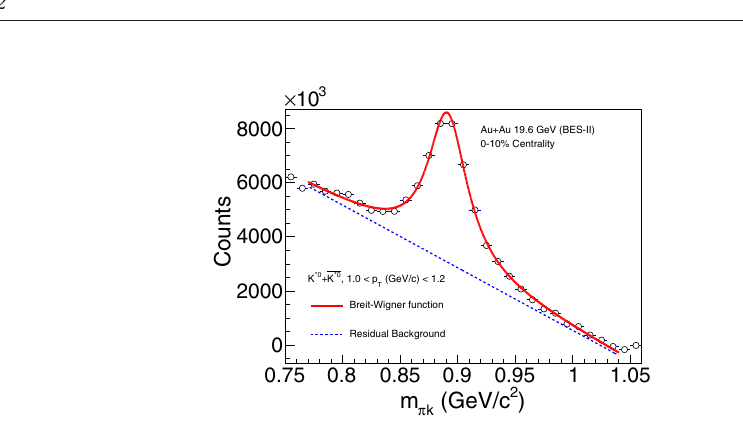
which is then fitted with the Breit-Wigner function and a first-order polynomial representing the residual background. Figure 1 shows an example of K ∗ 0 signal extraction for 1.0 < p T < 1.2 GeV / c in 0-10% Au + Au collisions at √ s = 19.6 GeV. The yield is estimated by NN integrating the signal within 0.77 < m π K < 1.04 GeV / c 2 after residual background